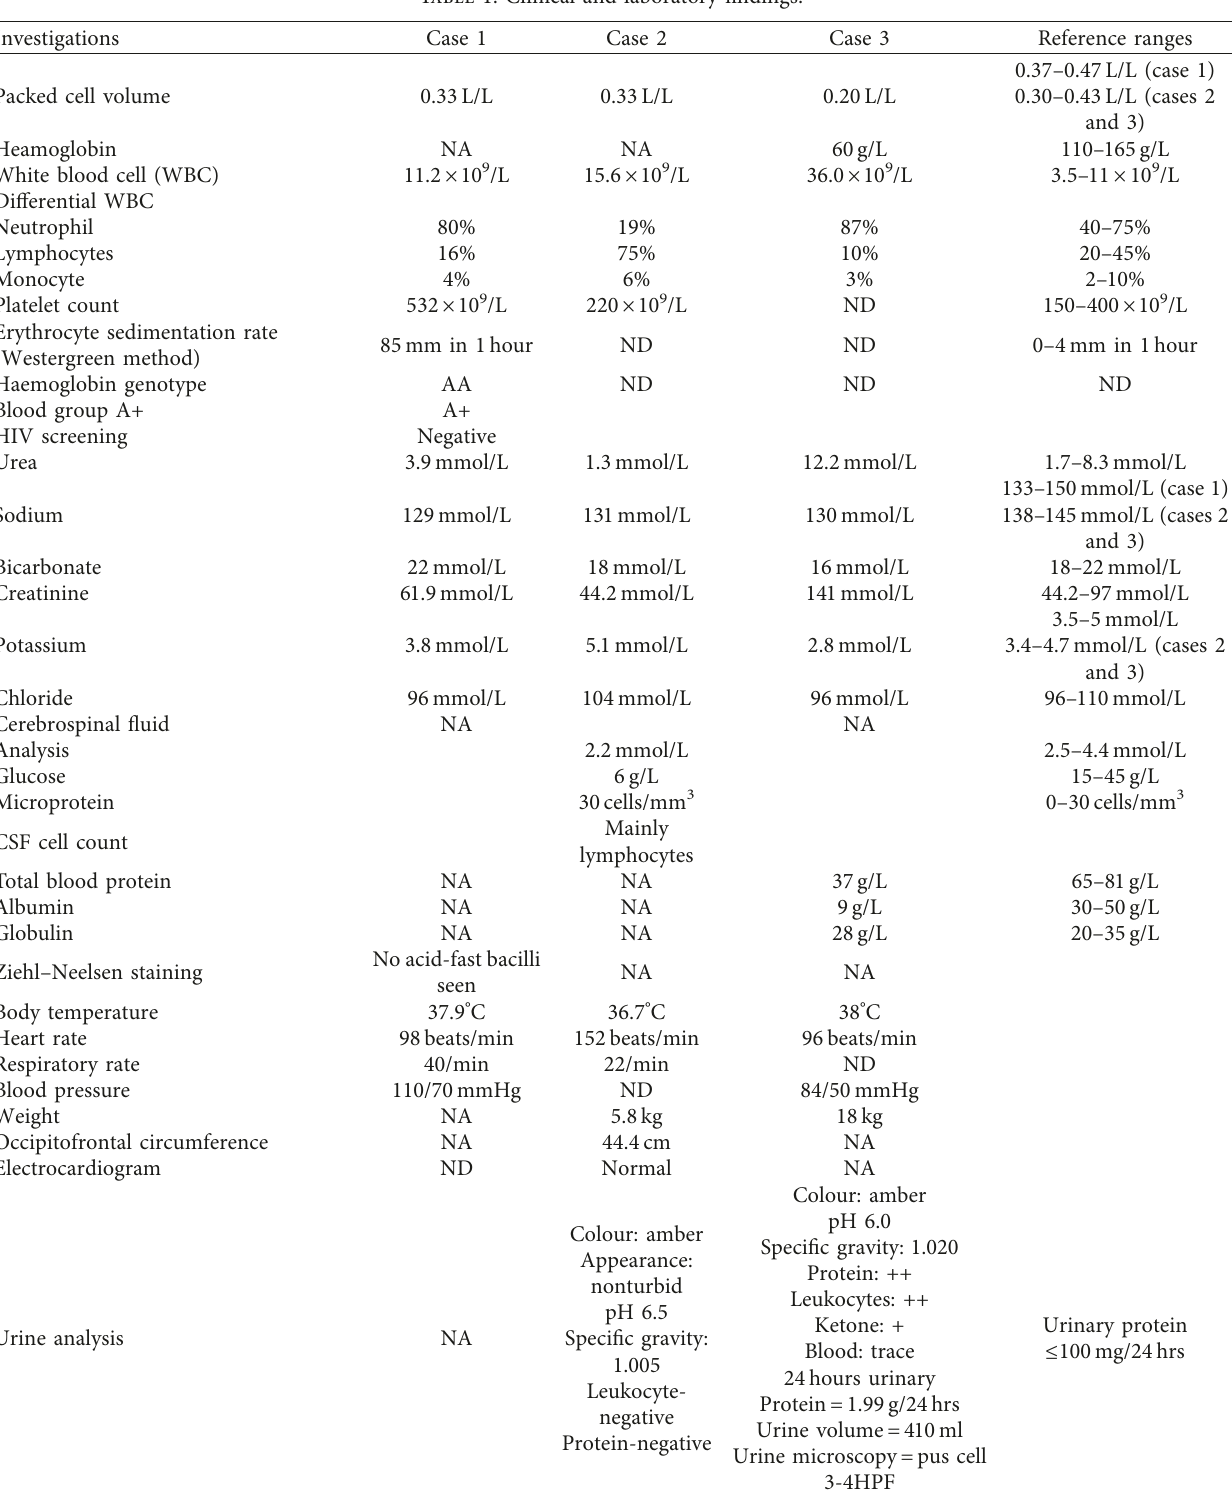
Table 1: Clinical and laboratory